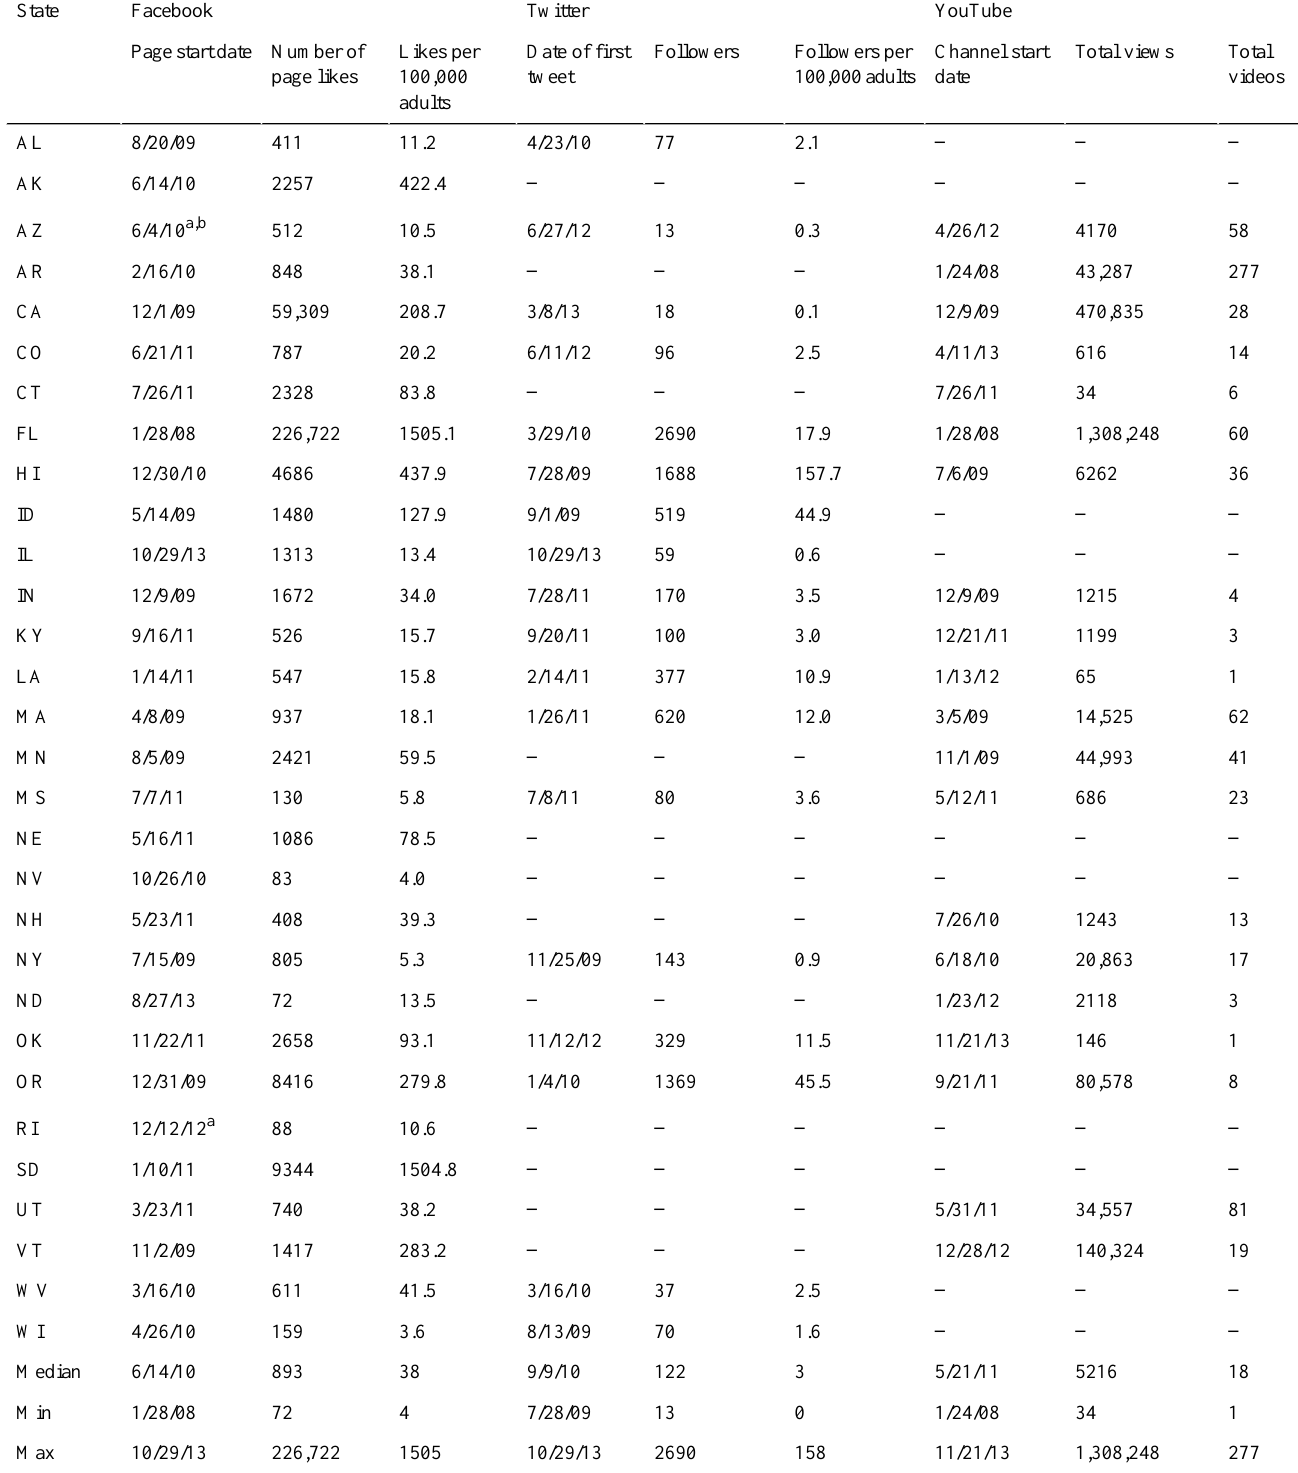
Table 1. Date of site establishment and reach metrics for TCP social media sites